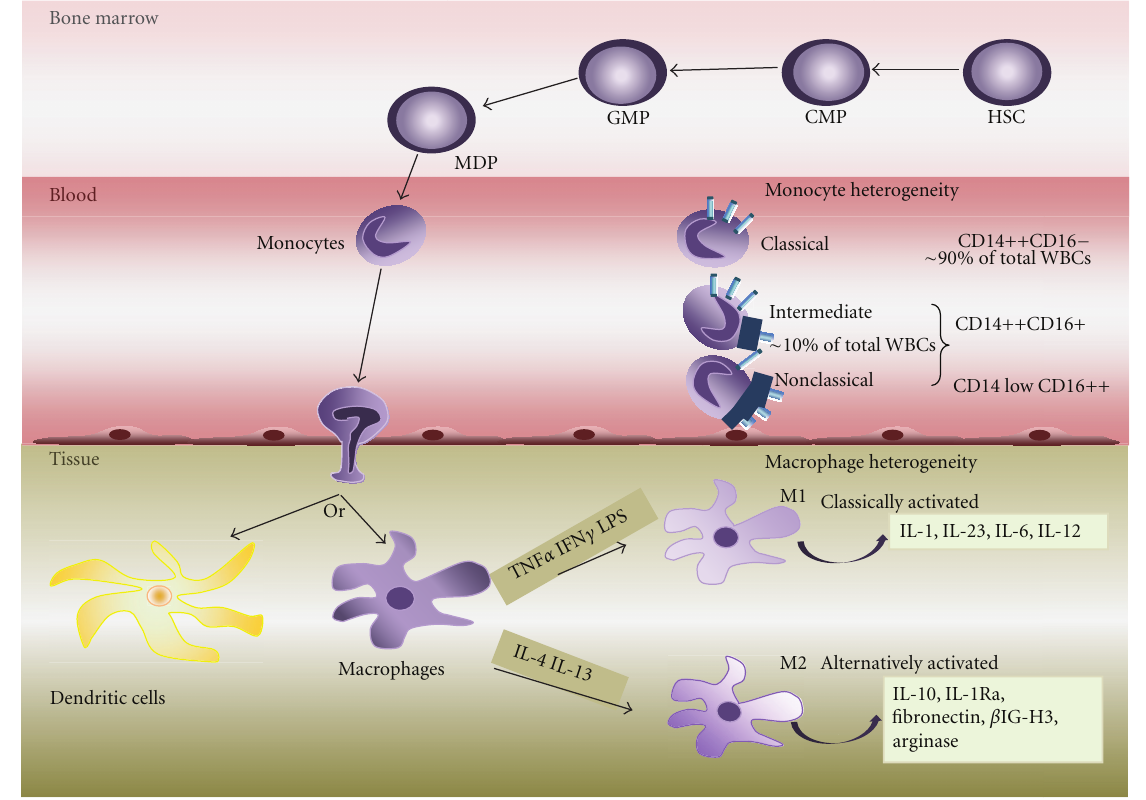
Figure 2: Monocyte and macrophage heterogeneity. Monocytes originate in the bone marrow where they develop from hematopoietic stem cells (HSCs) via several di ff erentiation steps and intermediate progenitor stages that pass through the common myeloid progenitor (CMP), the granulocyte/macrophage progenitor (GMP), and the macrophage/DC progenitor (MDP) stages. The MDP gives rise to monocytes, which are released in blood circulation where they remain for 1–3 days. In peripheral blood, circulating monocytes represent ∼ 5–10% of peripheral blood white blood cells (WBCs) and are a highly heterogenic population. Three main subtypes have been described based on the expression of CD14 and CD16 receptors: the classical CD14++CD16, intermediate CD14++CD16+, and nonclassical CD14 low CD16++ monocytes. In general, circulation monocytes are recruited to tissues where they can di ff erentiate into dendritic cells or tissue macrophages (Kup ff er cells in the liver; microglial cells in the brain, etc.), replenishing the existing populations. Additional heterogeneity also exists between the macrophages, with two major classes being identified: the classically activated (M1) and the alternatively activated (M2) macrophages. M1 macrophages are developed in response to TNF α and IFN γ as well as in response to microbial products such as LPS, and they produce in turn proinflammatory cytokines including IL-1, IL-23, IL-6, and IL-12. M2 macrophages can develop in response to IL-4 and IL-13 cytokines and play important roles in down-regulation of inflammation and tissue remodelling by releasing IL-10 and IL-1 receptor antagonist (IL-1Ra). They also produce high levels of arginase, fibronectin, and a matrix-associated protein, β